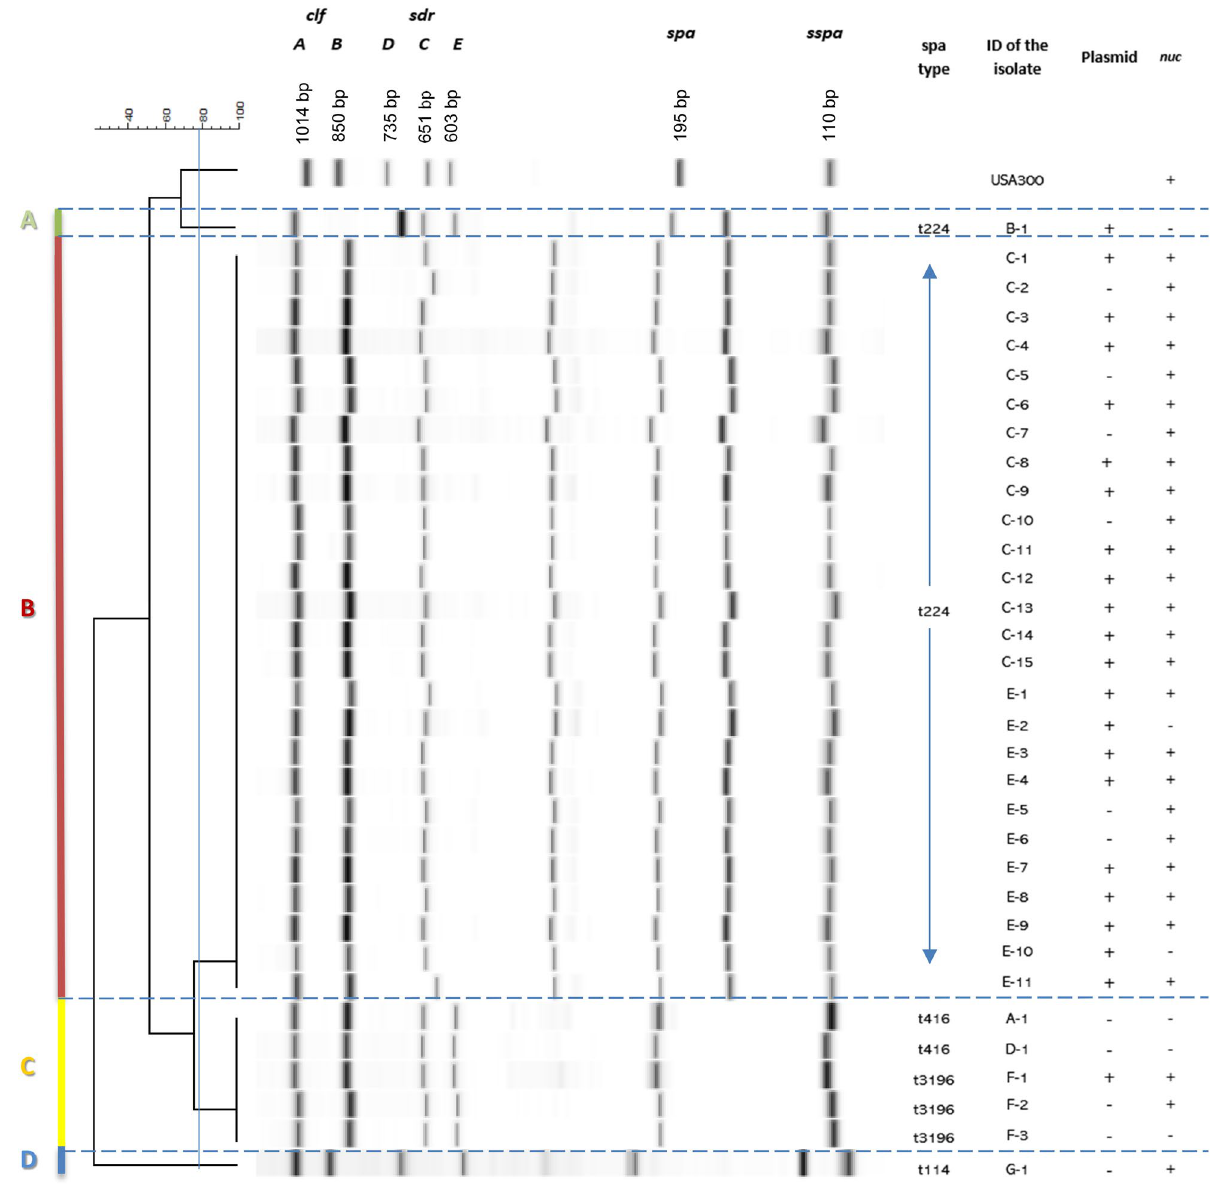
Figure 2. MLVF dendrogram of 33 S. aureus isolates from cows with mastitis. PCR fragments of seven VNTRs of S. aureus were separated on a Bioanalyzer 2100 with microfluidic DNA 7500 chips. The dendrogram was constructed in silico from CSV files of the Bioanalyzer runs using GelCompar II software (Applied Maths; https:// www. appli ed- maths. com/ gelco mpar- ii). The PCR fragments ( clfA [1014-bp], clfB [850-bp], sdrD [735-bp] sdrC [651-bp] sdrE [603-bp], spa [195-bp] sspA [110-bp]) obtained for the control DNA of S. aureus USA300 are indicated. For the generation of the dendrogram, a cut-off value of 81% was used, yielding a concordance of 0.980. The respective MLVF clusters (A-D), the respective spa -types, and the presence of the nuc gene and plasmid pSAM1 are specified. The Figure was created with Microsoft PowerPoint